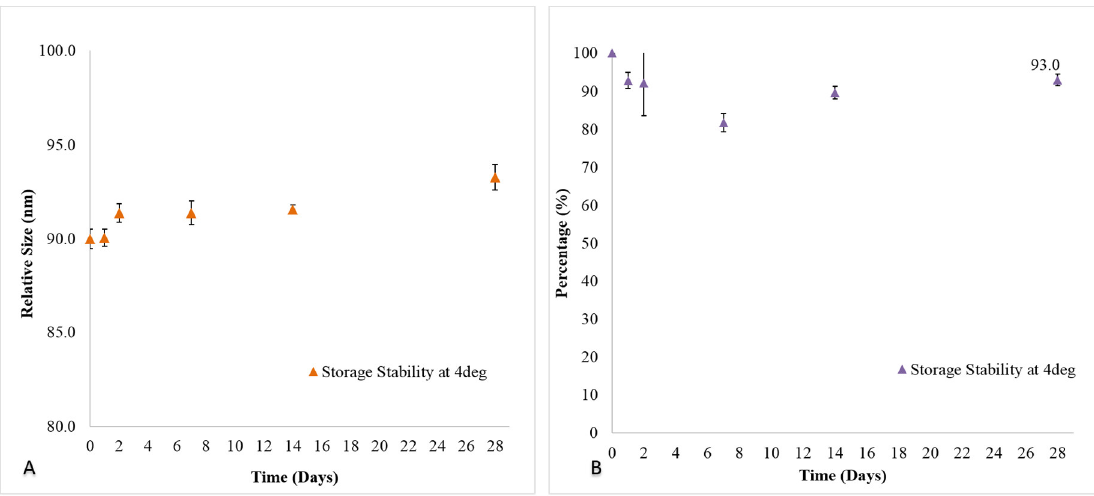
Figure 1. ( A ) Size and ( B ) drug loading stability of Senicapoc-loaded liposomal formulation at 4 °C storage conditions over a period of 28 days. All data are reported as mean ± SD of triplicates.